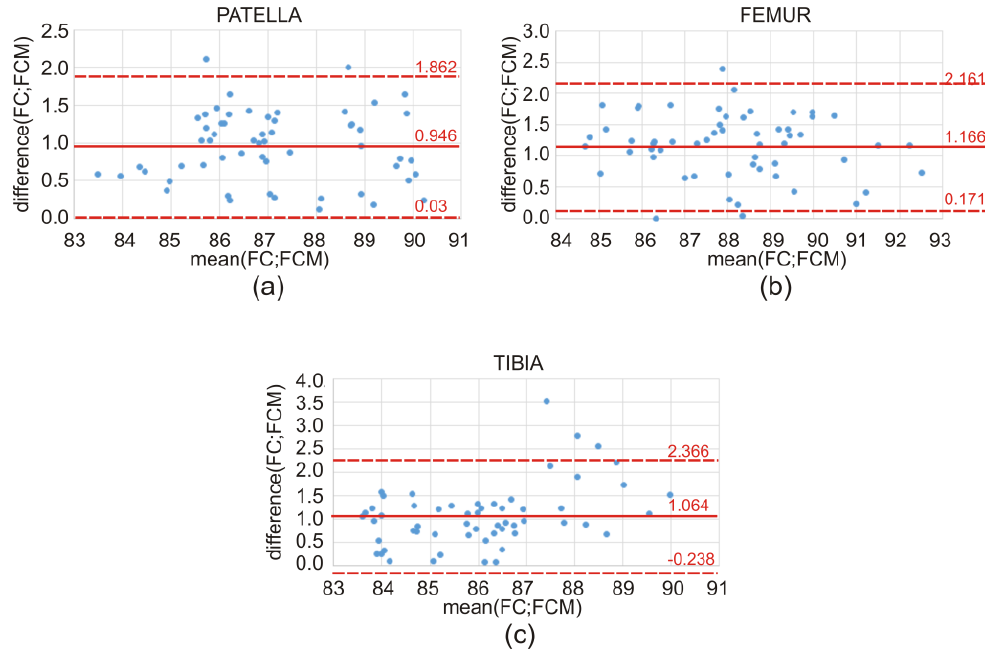
Figure 10. Discrepancy in the obtained values of the Dice index between the FC and FCM methods for T1-weighted MRI studies of the knee joint on the sagittal plane, illustrated using Bland–Altman plots, for the ( a ) patella, ( b ) femur, and ( c ) tibia, respectively.